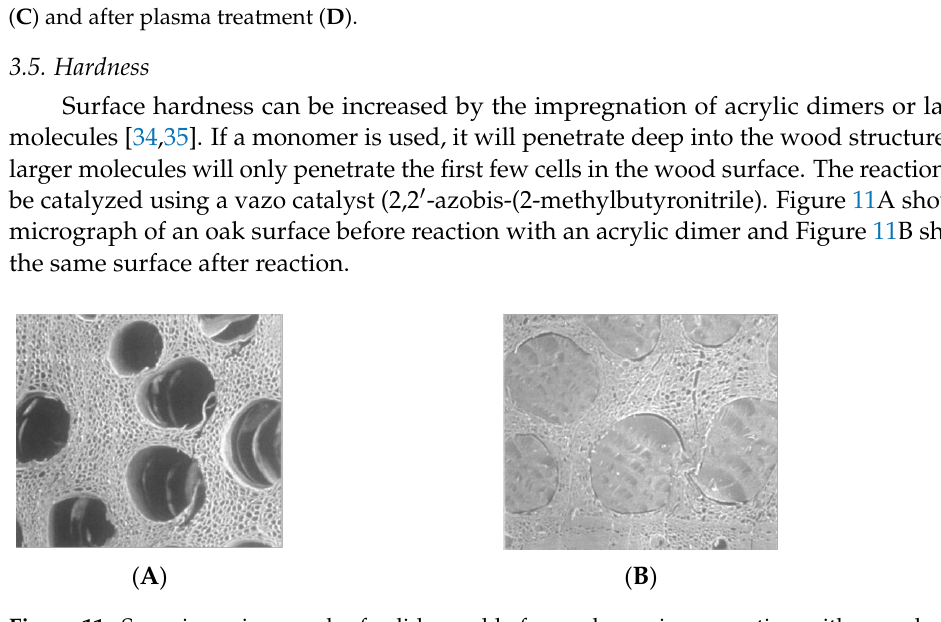
Figure 12. Effect of compression on specific gravity. Figure 13 shows the physical change of a wood surface as a result pf compression. ( A ) ( B ) ( C ) Figure 13. Structure of surface compressed southern pine ( A ) and oak before ( B ) and after compres- sion ( C ). The wood surface can also be laminated, for example, by pressing a layer of heavy- duty melamine containing paper [42,43]. The laminate can have many different types of decorative design. A wood grain pattern can be used but many other designs and colors